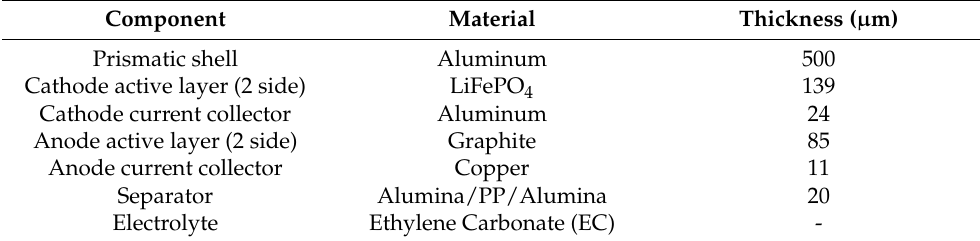
Figure 1. The photos of lithium-ion prismatic cells and internal component materials: ( a ) Prismatic shell and interior; ( b ) Internal component materials. Table 1. Specifications of the prismatic cells and internal